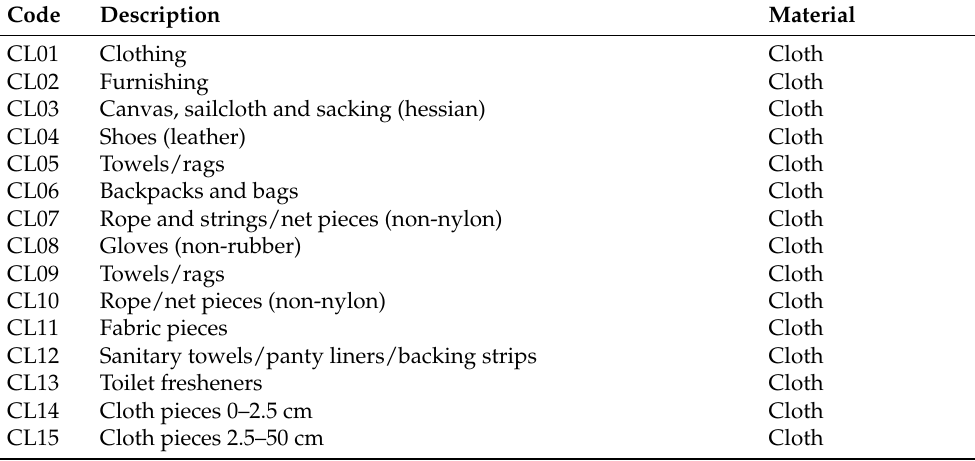
Table A1. Category codes and description for litter items in the 12-site